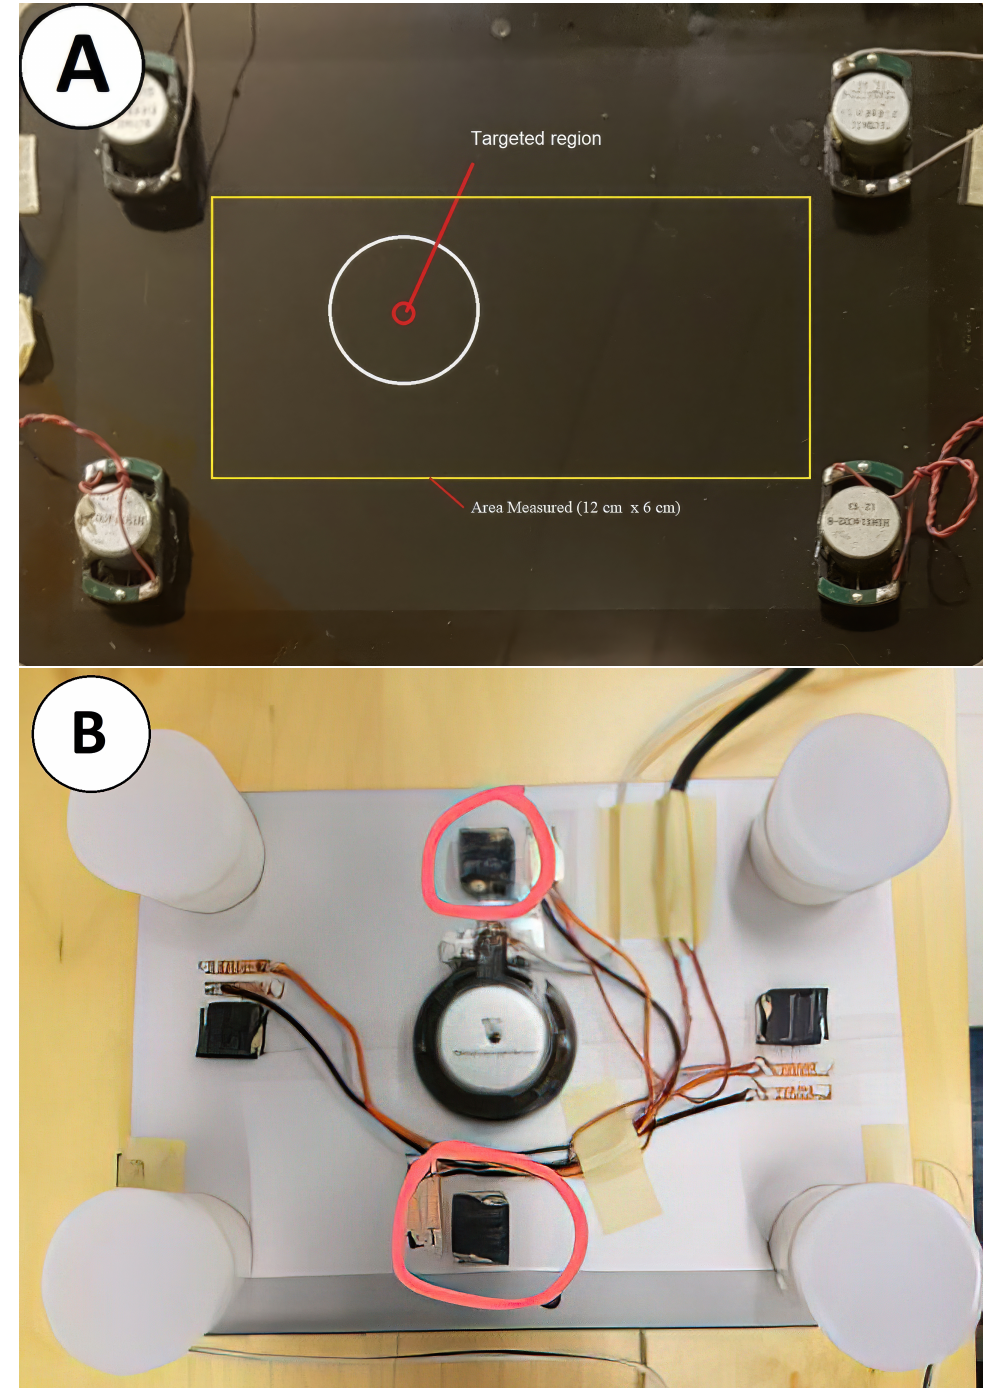
Figure 2. ( A ) View of the top of tablet display surface used, the Surface Go. Four tectonic actuators can be seen placed at each corner. ( B ) L5 actuators can be seen placed along the ends of the X and Y -axes of the tablet